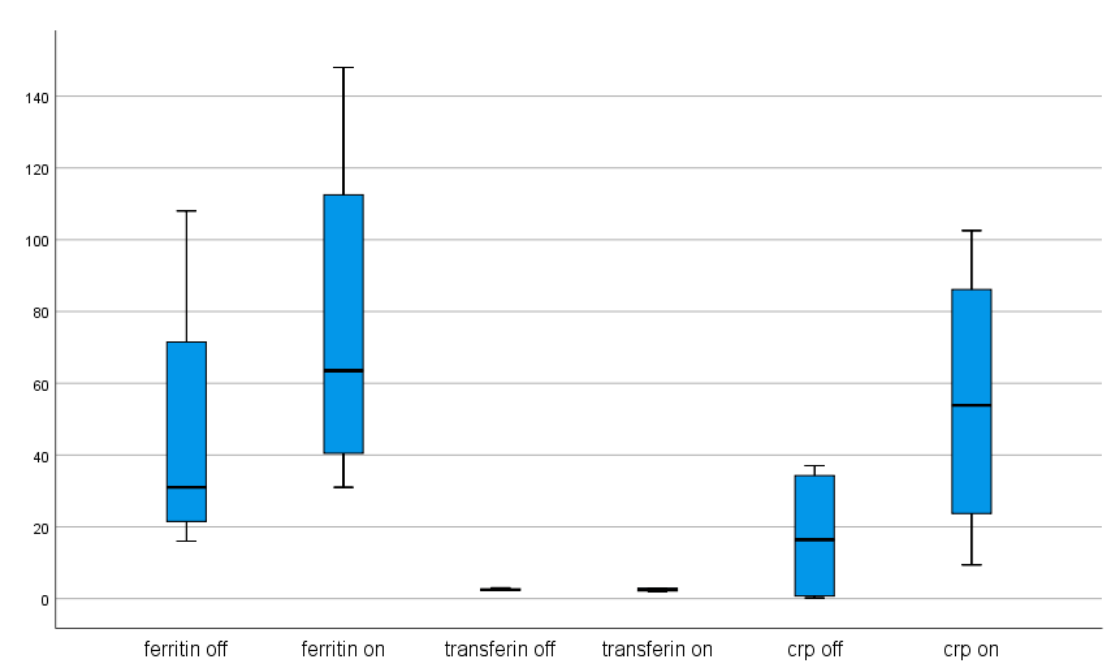
Figure 7. Effect of spinal cord stimulation (SCS) on ferritin (ng/L), transferrin (g/L), and CRP (mg/L) concentrations.